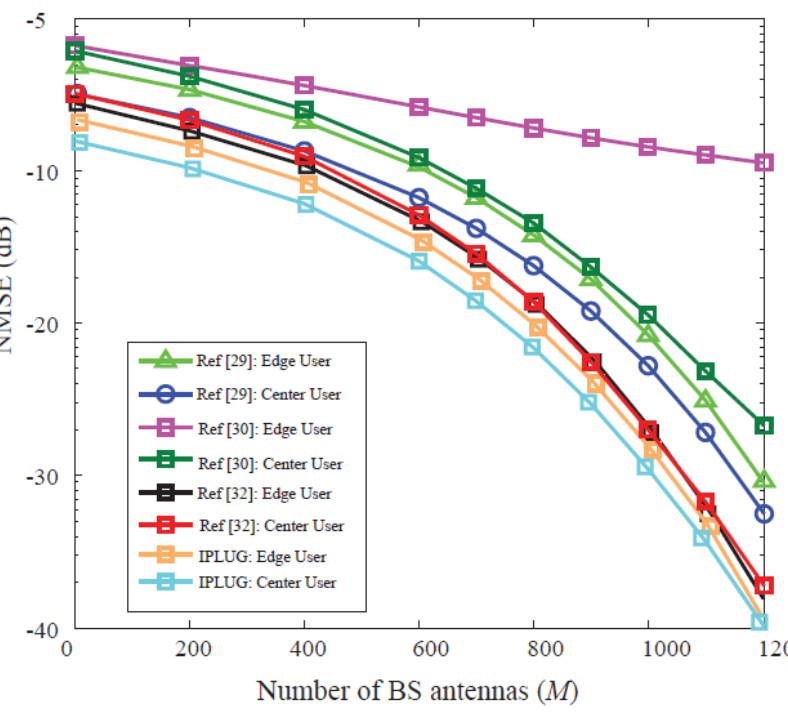
Figure 19. NMSE comparison of IPLUG and conventional algorithms.